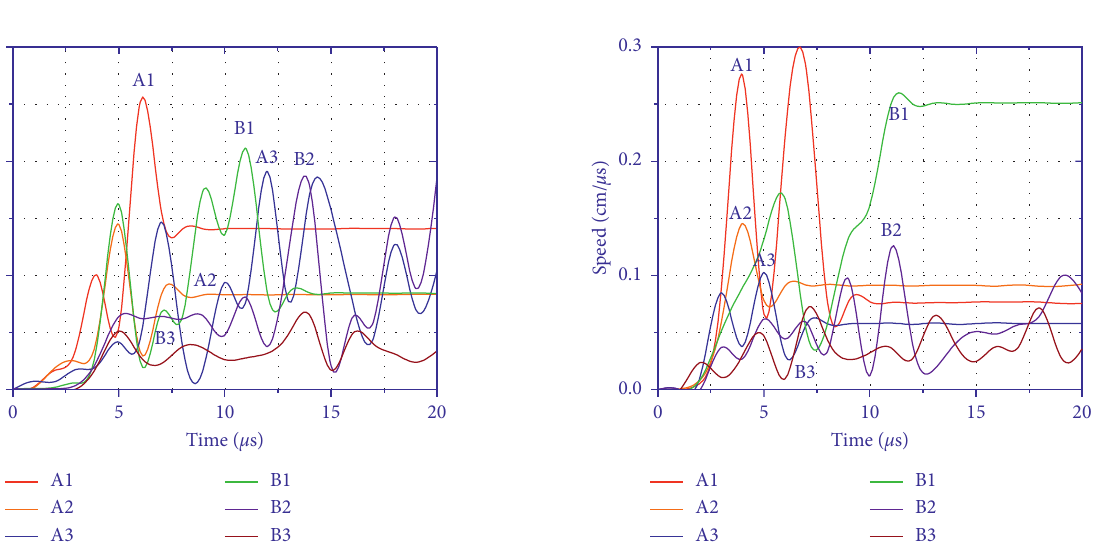
Figure 21: The joint velocity curve of anhydrous bag-charge blasting.